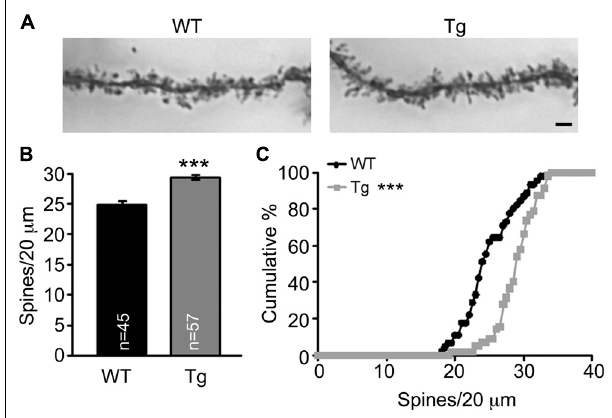
FIGURE 2 | Sarm1 knockdown increases dendrite spine density in the hippocampal CA1 region. (A) The representative images of CA1 neuronal Golgi stains are shown. (B) The mean ( ± SEM) and (C) cumulative probability of the numbers of dendritic spines were compared betweenWT and Sarm1 knockdown CA1 neurons.The scale bars are set at 5 μ m.The sample sizes ( n ) of the dendrite number are indicated in the panels.The data were collected from 15 to 19 neurons from 4WT to 4 Sarm1 knockdown mice, respectively. *** P <